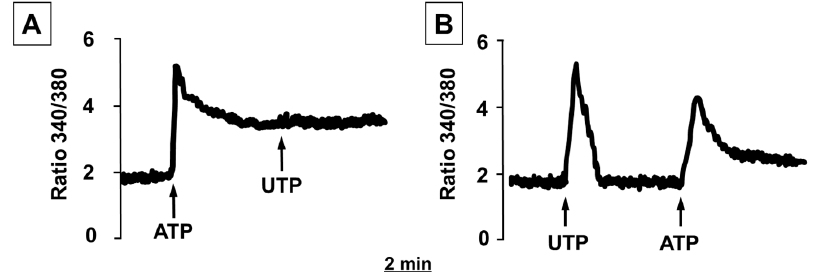
Figure 4. Effects of different nucleotides (100 μ M) on intracellular calcium concentrations in human adipocytes. The effects of the different nucleotides have been normalized to those obtained with ATP. * p < 0.05; ** p < 0.0001.